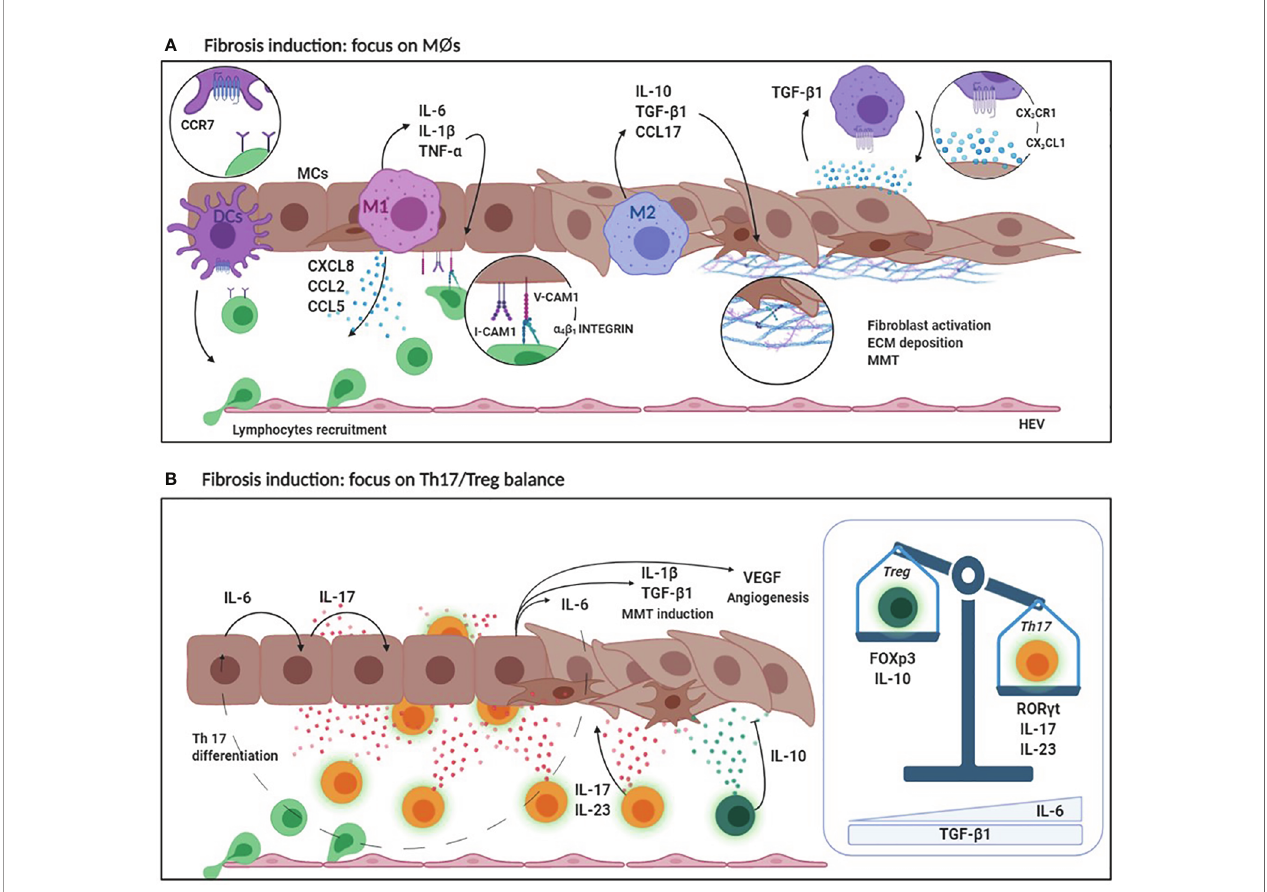
FIGURE 3 | (A) Fibrosis induction: focus on MØs. DCs secrete high levels of CCR7 favoring lymphocyte recruitment. Pro-in fl ammatory M1 MØs secrete CCL2, CCL3 and CXCL8 that are chemoattractant for lymphocytes and monocytes. At the same time, M1 MØs produce in fl ammatory cytokines such as IL-6, IL-1ß and TNF- a that enhance the expression of adhesion molecules (V-CAM1/I-CAM1) by MCs promoting leukocyte adhesion. M2 MØs produce anti-in fl ammatory cytokines (IL-10) and lymphocyte chemoattracting chemokines (CCL17). Predominance of M2 MØ response leads to an increased TGF-ß1 secretion that induces MMT of MCs with up-regulation of ECM protein production. Moreover, MCs secreting CX3CL1 recruit MØs expressing CX3CR1. Receptor/ligand interaction determines a positive loop that promote, in turn, CX3CL1 and TGF-ß1 expression. (B) Fibrosis induction: focus on Th17/Treg balance. The production of IL-6 by MØs and MCs during the in fl ammatory process promotes IL-17 production by the peritoneal stroma which, in combination with IL-23, promotes the differentiation of Th17 lymphocytes. IL-17 promotes IL-1ß, TGF-ß1, VEGF and IL-6 production causing MMT induction and neoangiogenesis. Th17 abundance affects the activity of regulatory T lymphocytes. Treg lineage has an anti-in fl ammatory activity (due to IL-10 production) and protects the peritoneal membrane by mediating tolerance mechanisms. High levels of IL-6 and TGF- ß 1 determine the predominance of Th17 over Treg with consequent peritoneal damage and fi